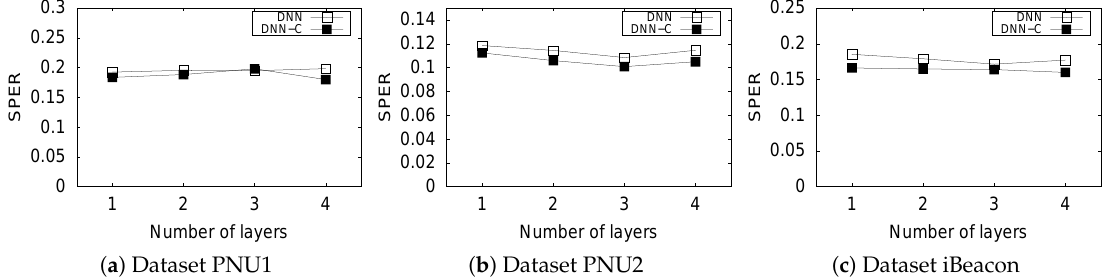
Figure 12. Performance of DNN and DNN-C with various hidden layers.